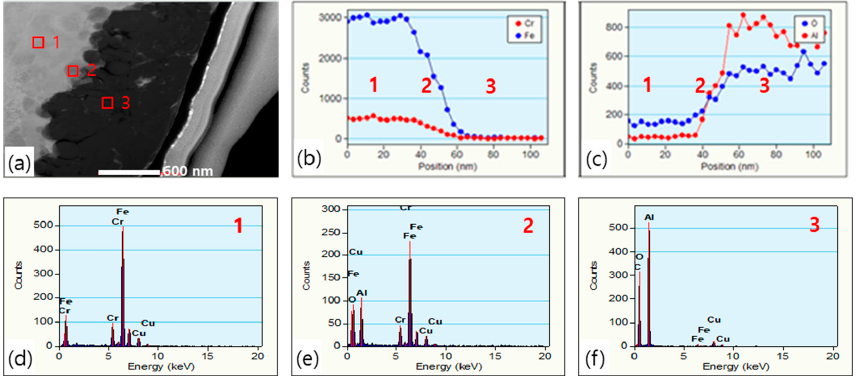
Figure 6. ( a ) Cross-sectional TEM image, ( b , c ) EDS line profile of areas 1, 2, 3, and ( d – f ) EDS atomic composition analysis of a Fe-12.5%Cr CSSF at areas 1, 2, 3.